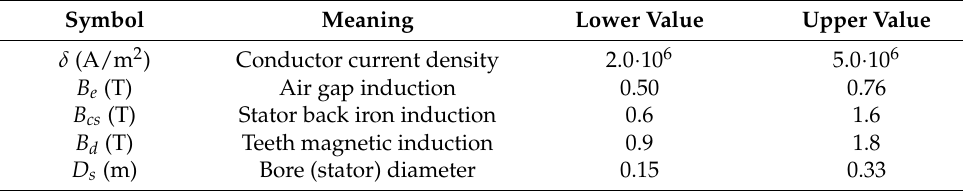
Table 1. Design parameters in the brushless DC motor benchmark.